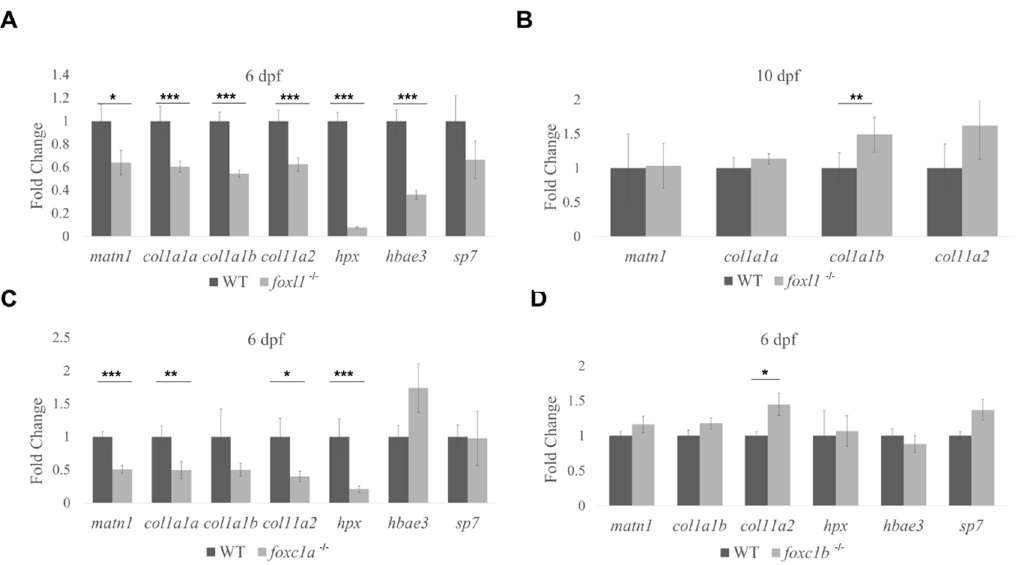
Figure 7. Differential gene expression in forkhead mutants. foxl1 -/- ( A ), foxc1a -/- ( C ), and foxc1b -/- ( D ) embryos at 6 dpf using TaqMan RT-qPCR to confirm genes of interest from RNA-Seq screen. Targets of interest were examined at 10 dpf in foxl1 mutants ( B ), demonstrating a recovery in gene expression. Fold change between WT and foxl1 -/- plotted with WT values set to 1 (* p < 0.05, ** p < 0.01, *** p < 0.001).